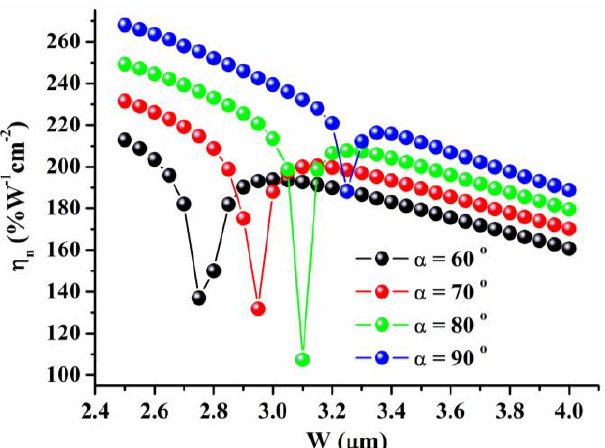
Figure 10. Normalized efficiency η n calculated as a function of rib width W in the range of 2.5–4.0 µ m for four different inclination angles: α = 60 ◦ , 70 ◦ , 80 ◦ and 90 ◦ . The other parameters are H = 1 µ m and h = 0.7 µ